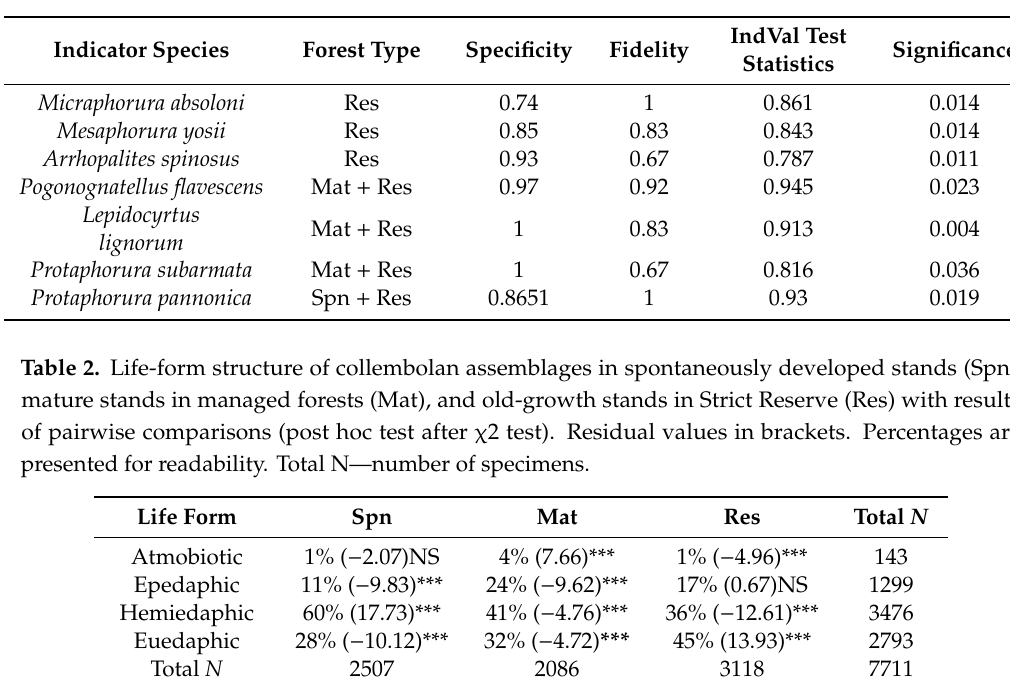
Table 1. Indicator species analysis of the collembolan assemblages in the di ff erent forest habitat types. Spn—spontaneously developed stands, Mat—mature stands in managed forests, Res—old-growth stands in Strict Reserve. Only significant results are displayed.